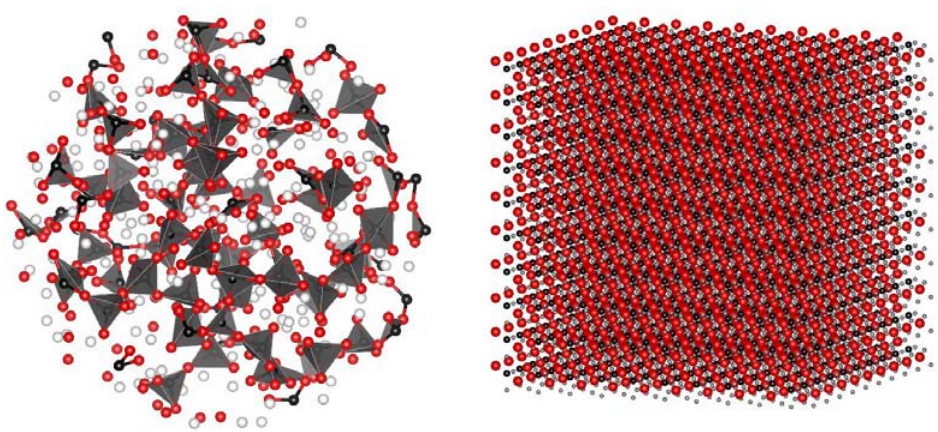
Figure 1. FLiBe MD molecular system, with black as Be 2+ ions, red as F - ions, and white as Li + ions. The BeF 42- clusters are shown as a tetrahedron structure (left). The FLiBe supercell used in the execution of the MD simulations (right).